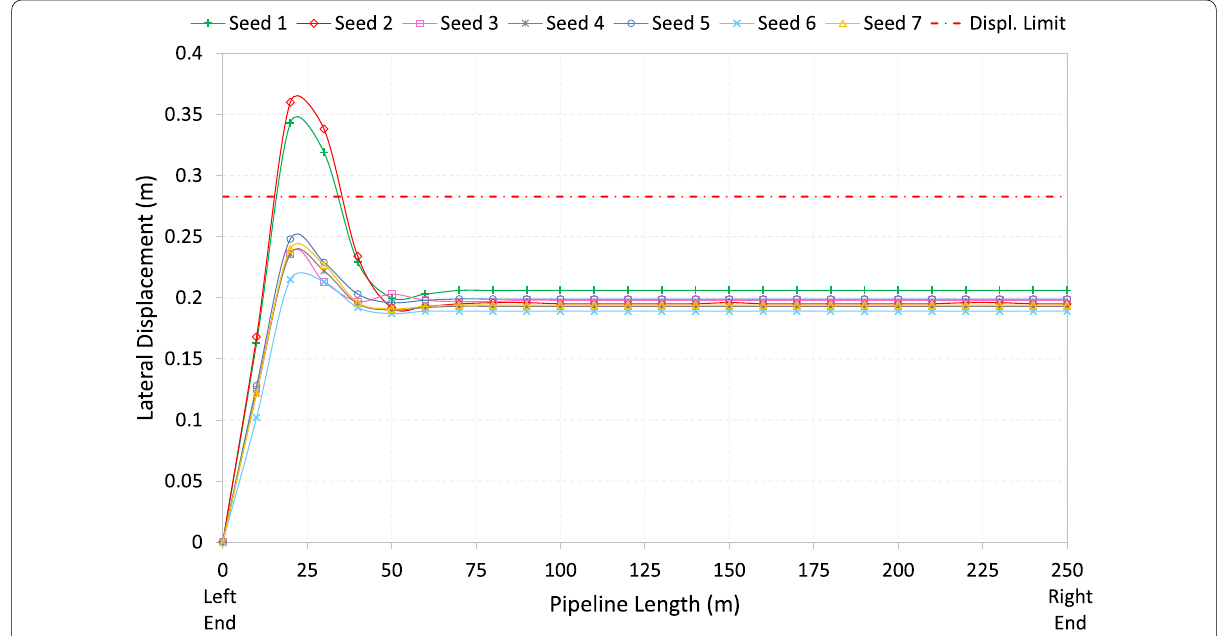
Fig. 14 Envelopes of the lateral displacements of the pipeline for the seven